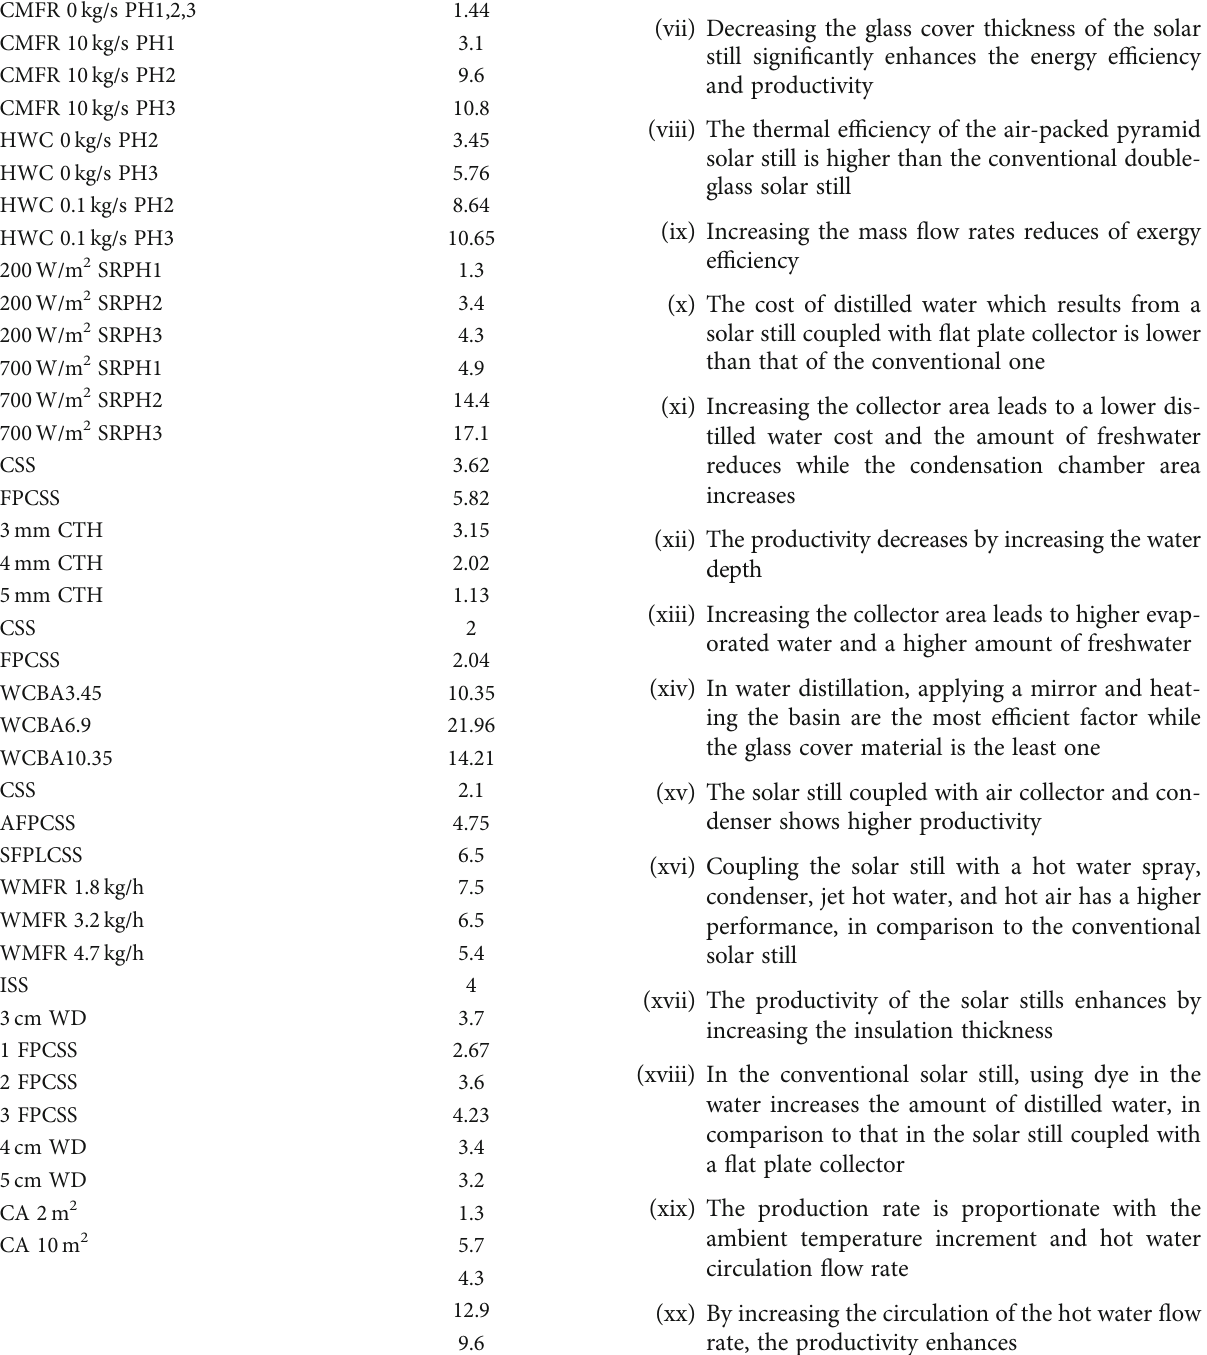
Table 3: Solar still productivity of studied references.